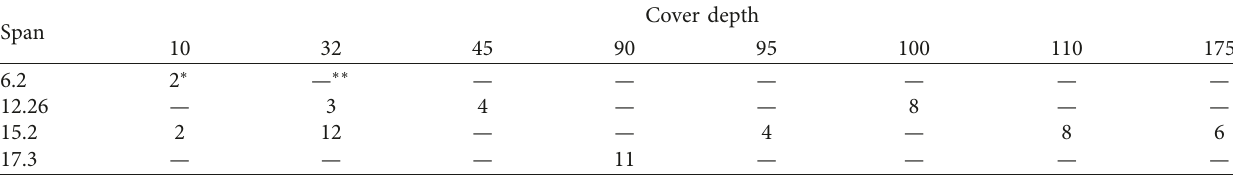
Table 3: Distribution of data on cover depth and span.